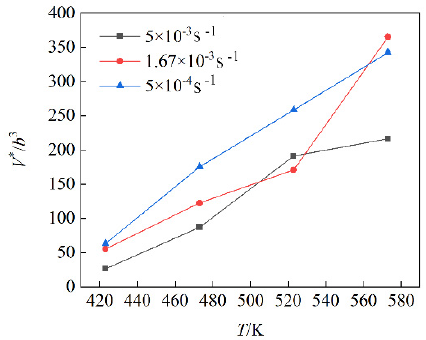
Figure 10. Normalized activation volume as a function of temperature at different strain rates.